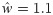
Integration or cancelation of top-down signals by modulatory VIP input.(A) PCs of the full microcircuit are stimulated at the soma and the apical dendrites with two oscillations with different frequencies, emulating bottom-up (orange, xE) and top-down (blue, xD) input, respectively. PC rate reflects the two inputs xE and xD with different coefficients α and β, depending on the modulatory input. (B) In an amplification regime (w^=1.1), weak, permanent modulatory VIP input is sufficient to switch between two operation modes, in which top-down input is either integrated (β > 0) or cancelled (β = 0). In the WTA regime, the network exhibits hysteresis, that is, the level of modulatory input needed to cause a switch depends on the network state. For a range of inputs, the circuit is bistable. (C) In the bistable regime (w^=1.2), persisting transitions between the states can be triggered by strong, short pulses delivered to VIP neurons (10 ms duration, amplitude 8.4/s, timing denoted by green arrows). Parameters (A-C): Weight between SOM neurons and dendrites w^DS=2.8, External stimulation xE = 25/s + 0.5 sin(5 t)/s, xD = 7/s + 0.1 sin(30 t)/s, xPV = 12/s, xSOM = xVIP = 3.5/s.